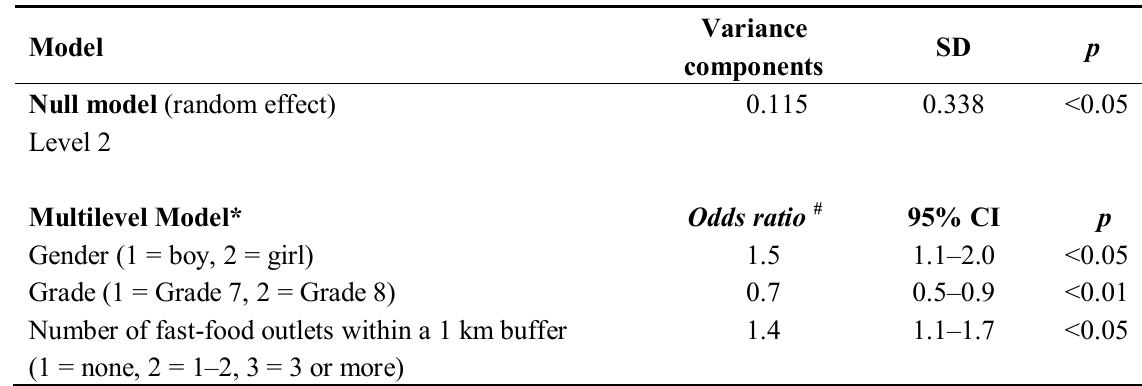
Table 5. School surrounding food environment and students’ self-fast-food purchasing behaviors (once per week or